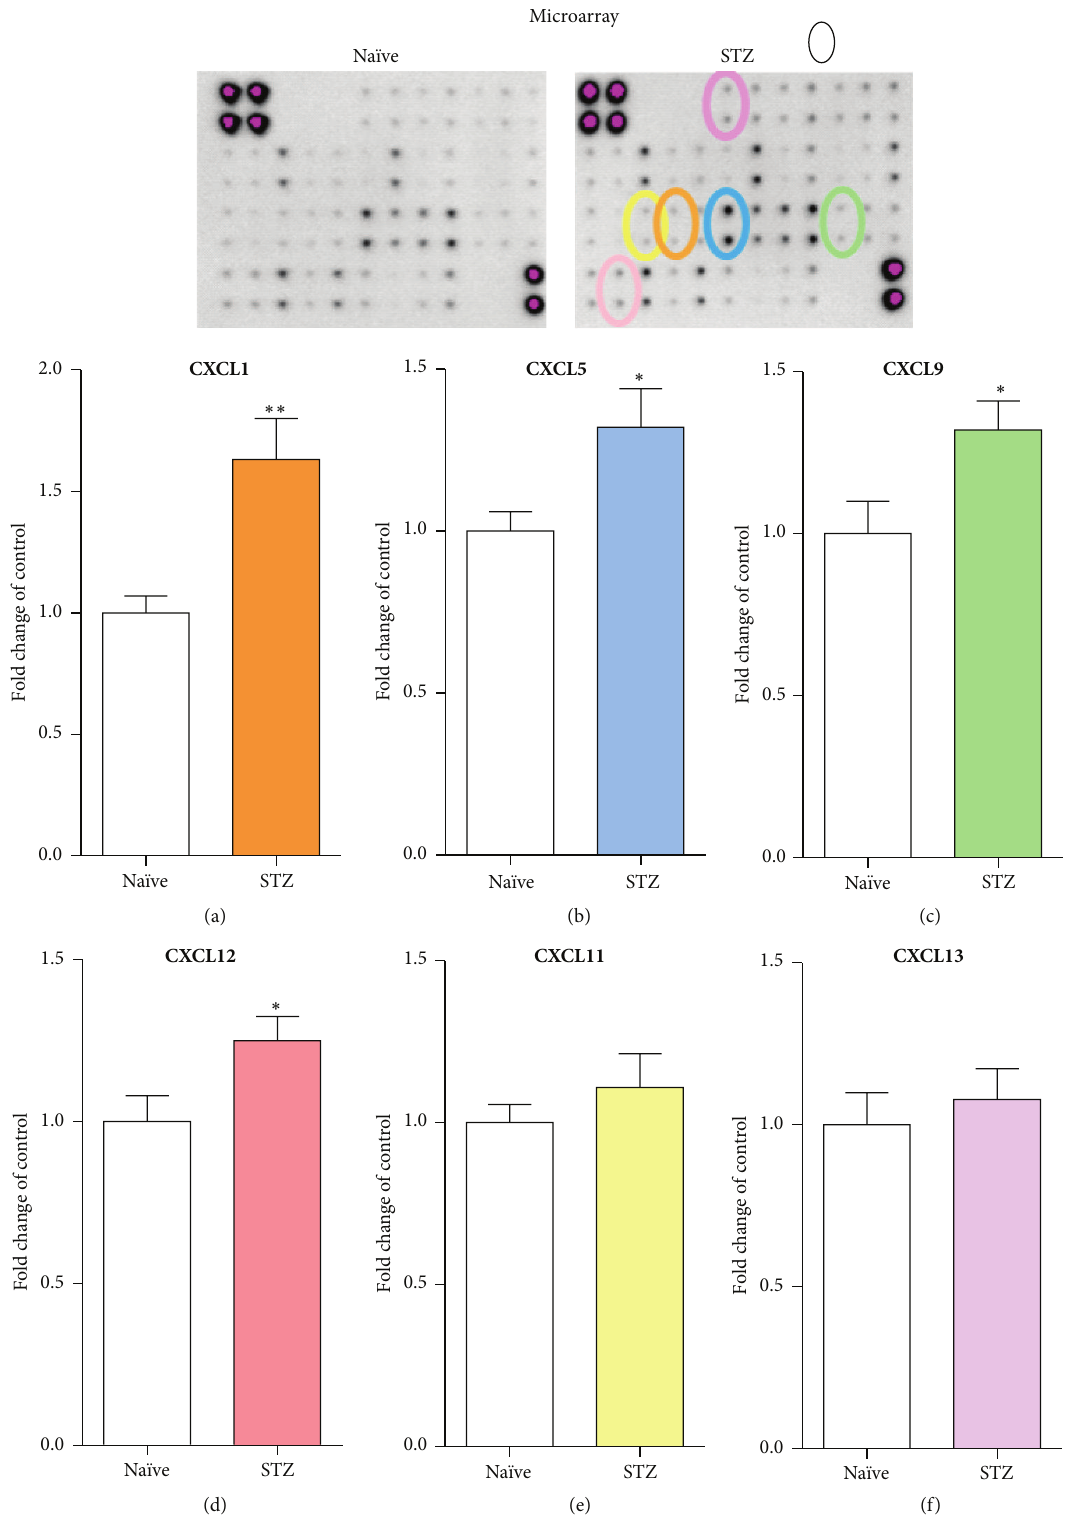
Figure 3: Streptozotocin- (STZ-) induced changes in chemokines from the CXC subfamily measured at day 7 in the mouse lumbar (L4–L6) portion of the spinal cord. The antibody array analysis of CXCL1 (a), CXCL5 (b), CXCL9 (c), CXCL11 (d), CXCL12 (e), and CXCL13 (f) protein level in na¨ıve and STZ-treated animals. The data are presented as fold change in the control (na¨ıve) ± S.E.M. (11-12 samples per group). The results were evaluated using Student’s 𝑡 -test. ∗ 𝑃 < 0.05 and ∗∗ 𝑃 < 0.01 indicate a significant difference compared with na¨ıve mice. STZ, streptozotocin-induced diabetic